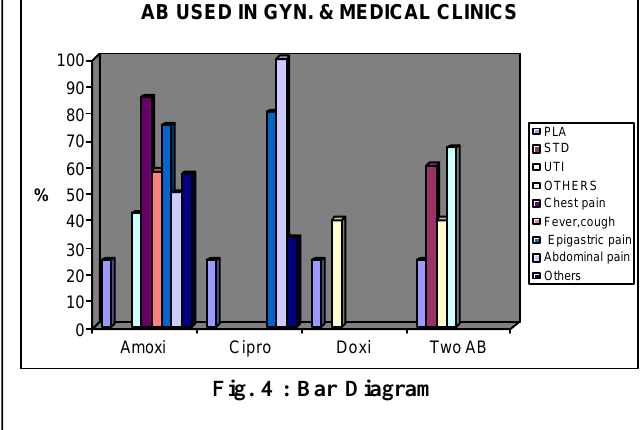
Fig. 4 : Bar Diagram